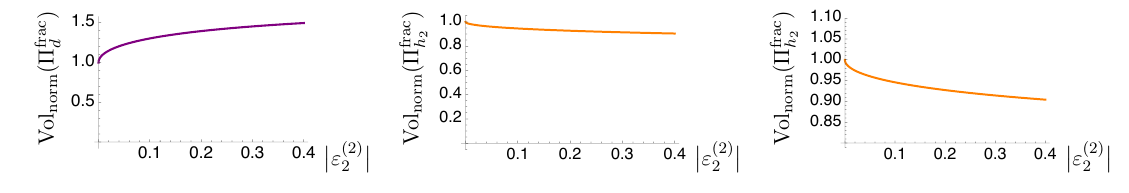
(cid:0) 2~ (cid:15) (2) 2 (cid:0) (cid:15) (2) 2 (cid:26) 1 + + (cid:5) frac = d d 0 2